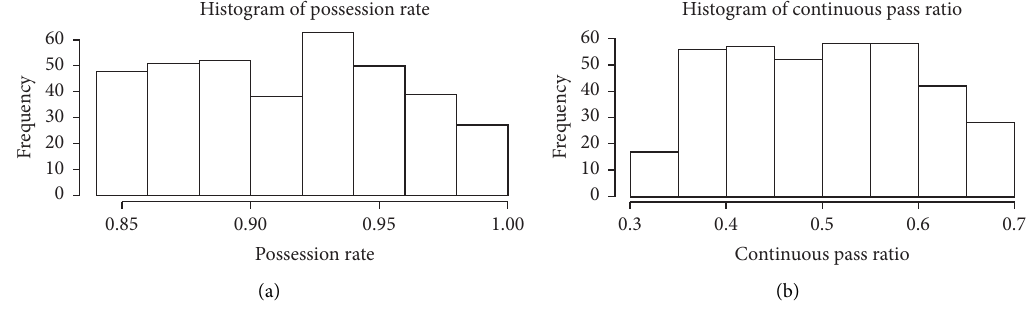
Figure 6: Distribution histogram of possession rate (a) and continuous pass rate (b) in 368